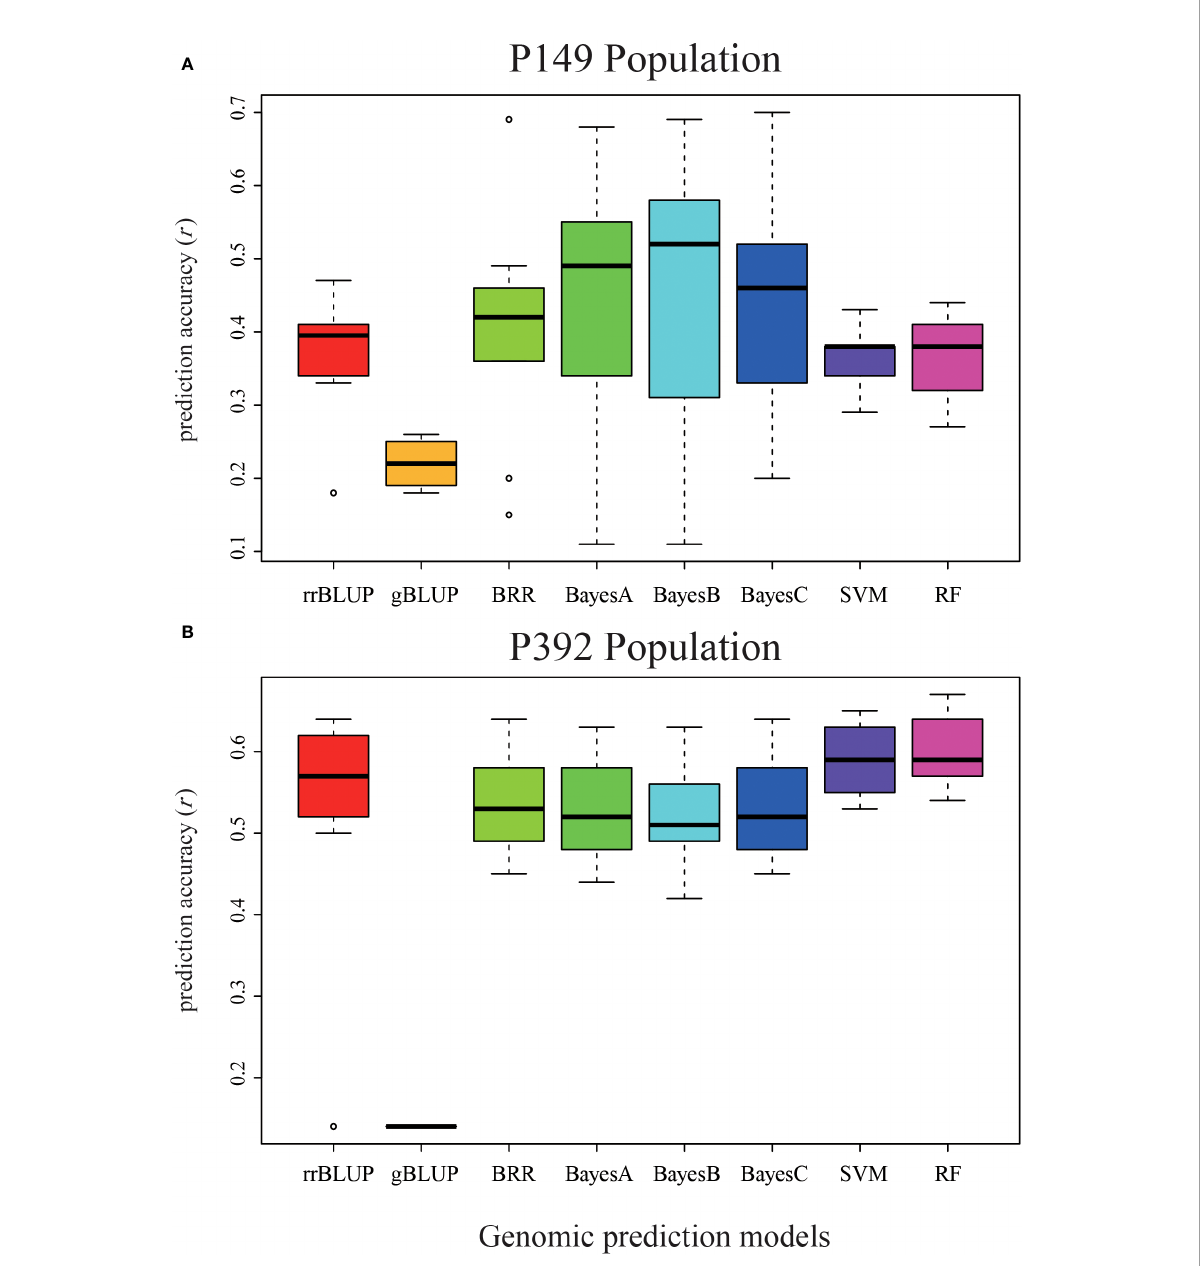
FIGURE 7 Validation of eight different models in the P149 and P392 populations. (A) The genomic prediction accuracy of total biomass yield in the P149 population was validated. (B) The genomic prediction accuracy of total biomass yield in the P392 population. rrBLUP, ridge-regression best linear unbiased prediction; gBLUP, genomic best linear unbiased prediction; BRR, Bayesian Ridge regression; BayesA, BayesianA; BayesB, BayesianB; BayesC, BayesianC; SVM, support vector machines; RF, random